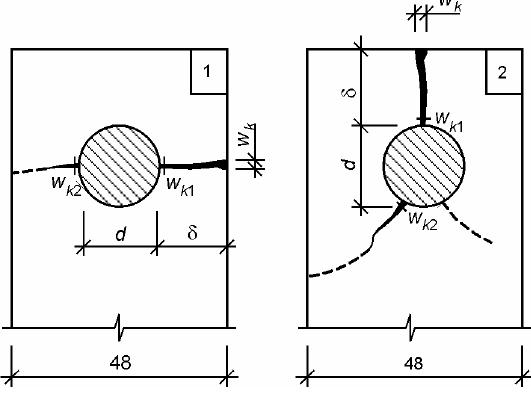
Fig 1. Steel corrosion-induced cases of cracking in the concrete (segments of cracks opened later by broken lines)